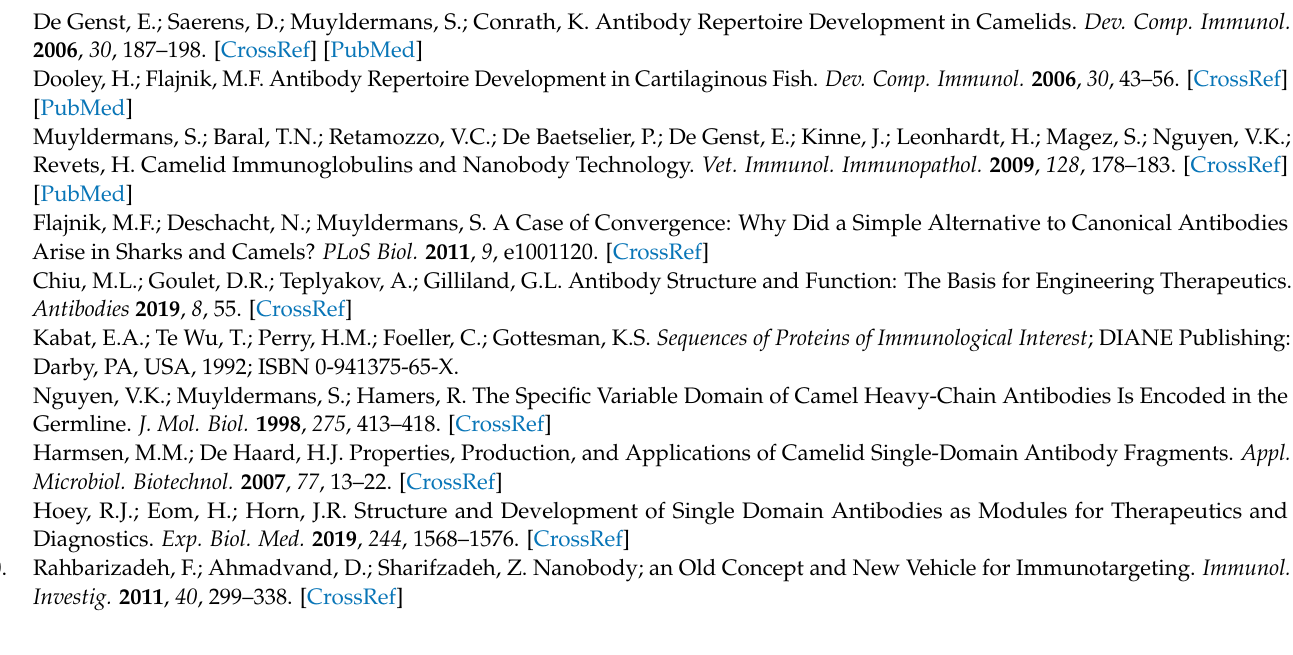
Figure S6: tICA plots using the backbone-torsions of the individual hypervariable loops as input features.; Figure S7: Contact analysis of the different bound